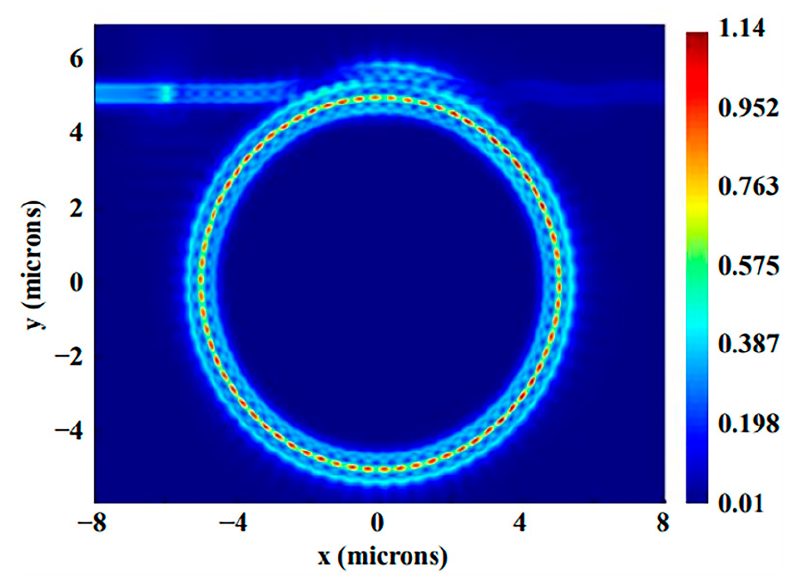
Figure 9. Electric field profile of mode